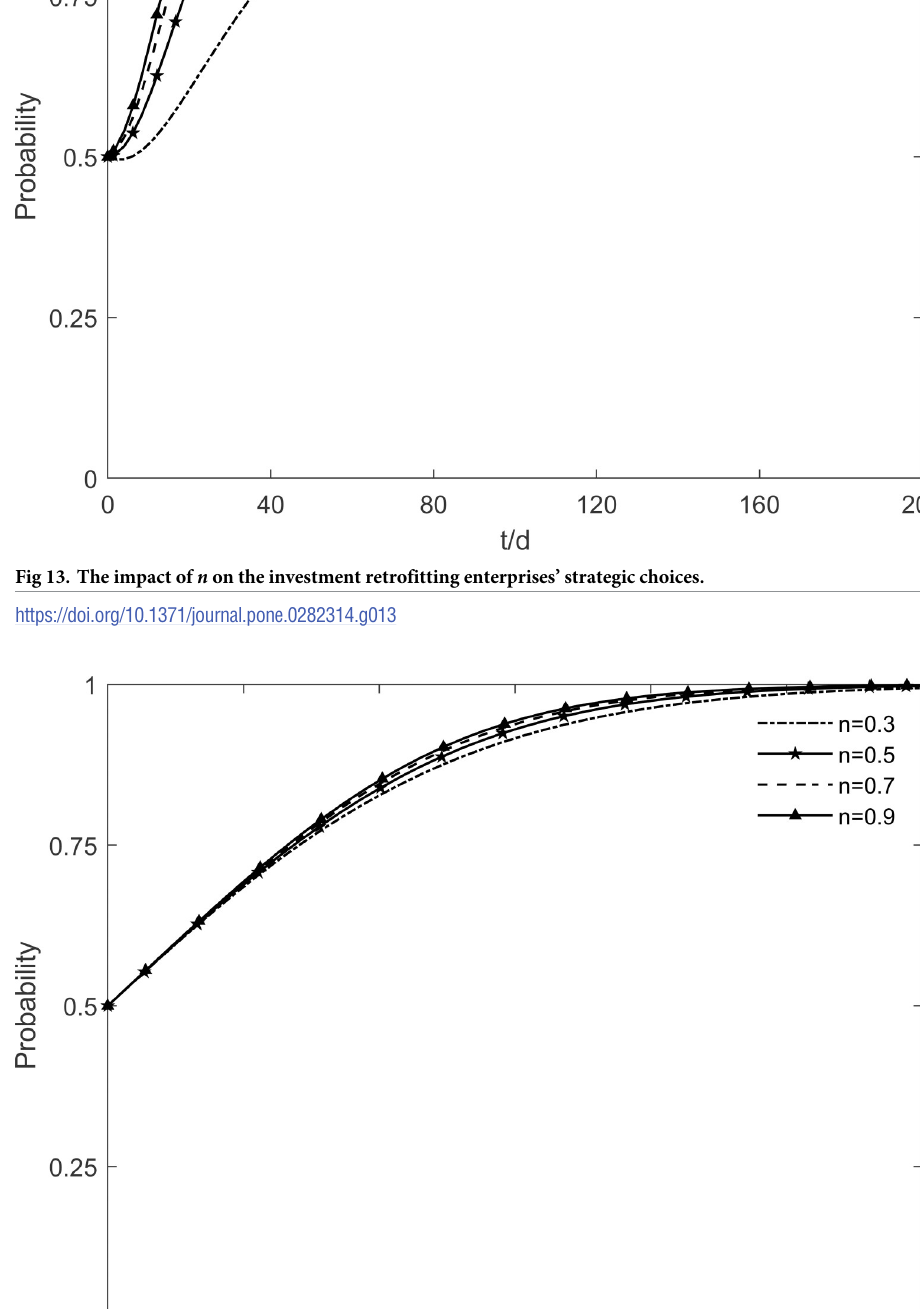
PLOS ONE | https://doi.org/10.1371/journal.pone.0282314 March 16,